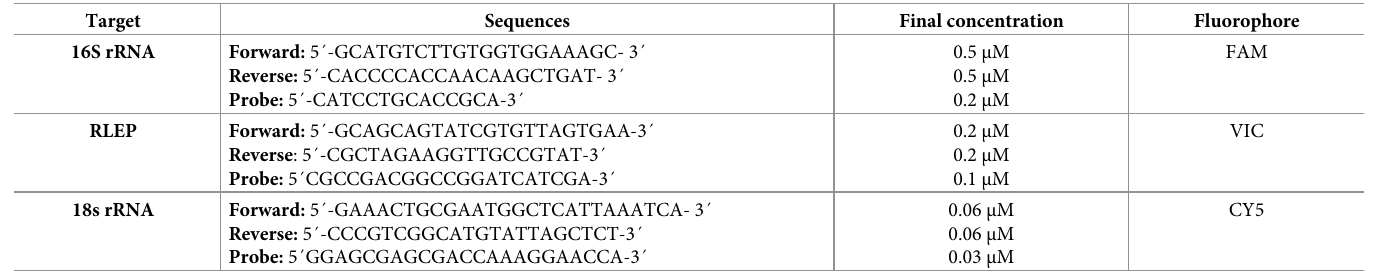
Table 2. Sequences, concentration, and fluorophores of the oligonucleotides contained in the multiplex qPCR assay. Target Sequences Final concentration